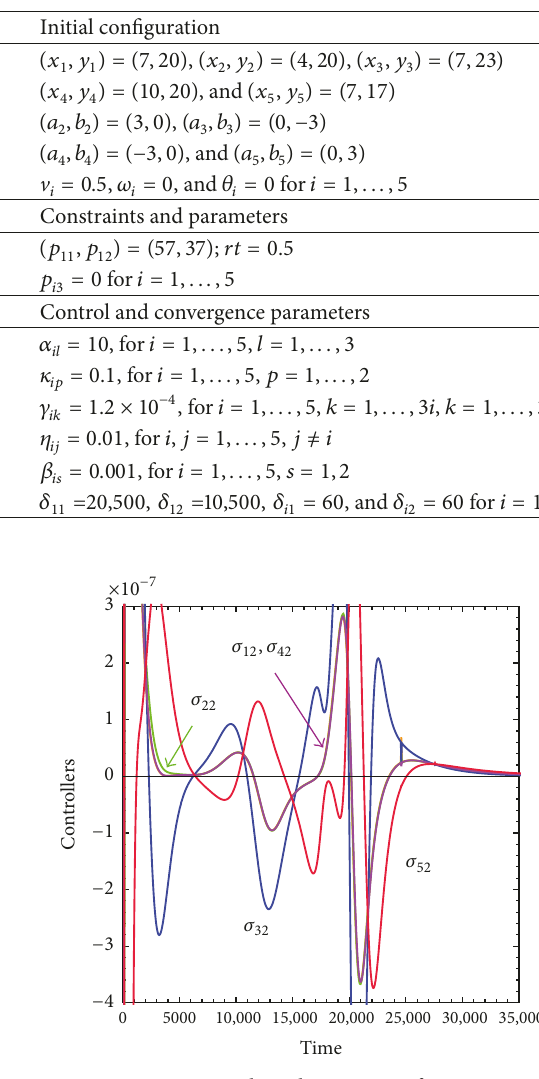
Figure 14: Rotational accelerations, 𝜎 2𝑖 for Scenario